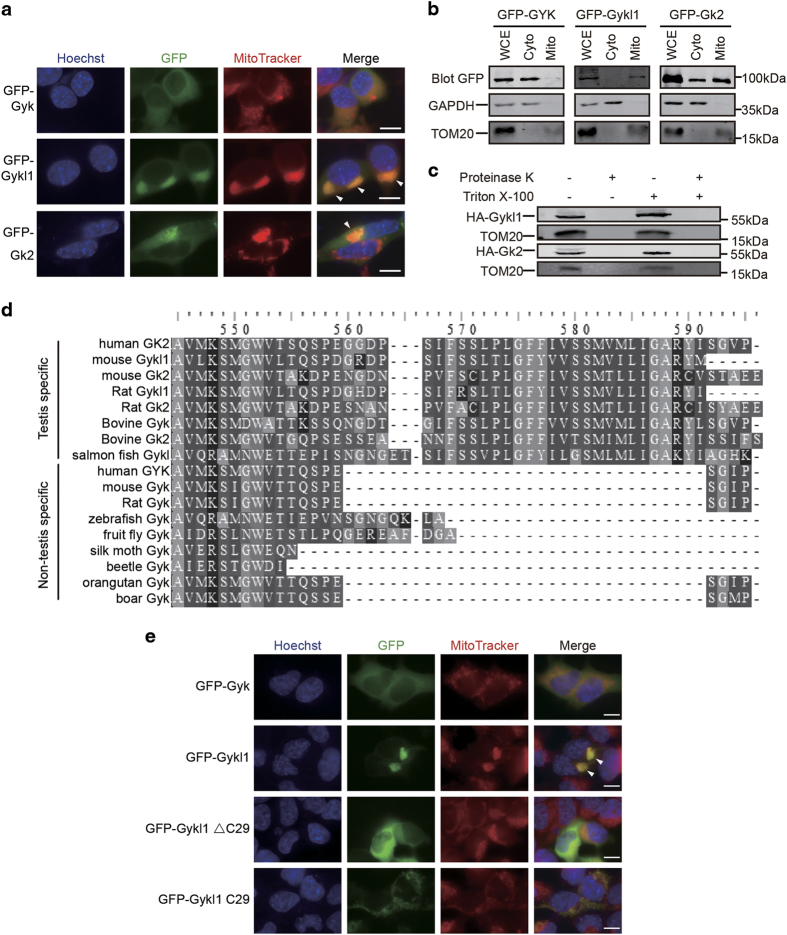
Gykl1 and Gk2 target to the outer membranes of the mitochondria through their unique C-terminal domains. (a) HEK293T cells transiently expressing various GFP-tagged proteins were stained with the MitoTracker dye to visualize the mitochondria. Arrows indicate areas of mitochondrial clustering. Hoechst 33342 was used to visualize the nuclei. Scale bar: 10 μm. (b) HEK293T cells transiently expressing GFP-tagged proteins were fractionated and blotted with antibodies against GFP. WCE, whole-cell extract. Cyto, cytoplasmic fraction, Mito, mitochondrial fraction. Antibodies against GAPDH and TOM20 served as loading control for the cytosolic and mitochondrial fractions respectively. (c) HEK293T cells transiently expressing HA-tagged Gykl1 and Gk2 were used to isolate mitochondrial fractions. The fractions were treated with proteinase K in the presence or absence of Triton X-100 before being immunoblotted with anti-HA antibodies. The antibody against TOM20, a mitochondria outer membrane protein, served as a positive control. (d) The C-terminal regions of Gyk-like genes from different species are aligned. Testis-specific genes appear to contain additional sequences in their C-termini compared with Gyk orthologues that are not restricted to testis. (e) HEK293T cells transiently expressing GFP-tagged Gyk as well as full-length and truncation mutants of Gykl1 were stained with the MitoTracker dye to visualize the mitochondria, and examined under a fluorescent microscope. Hoechst 33342 was used to visualize the nuclei. Arrows indicate areas of mitochondrial clustering. Scale bar, 10 μm.